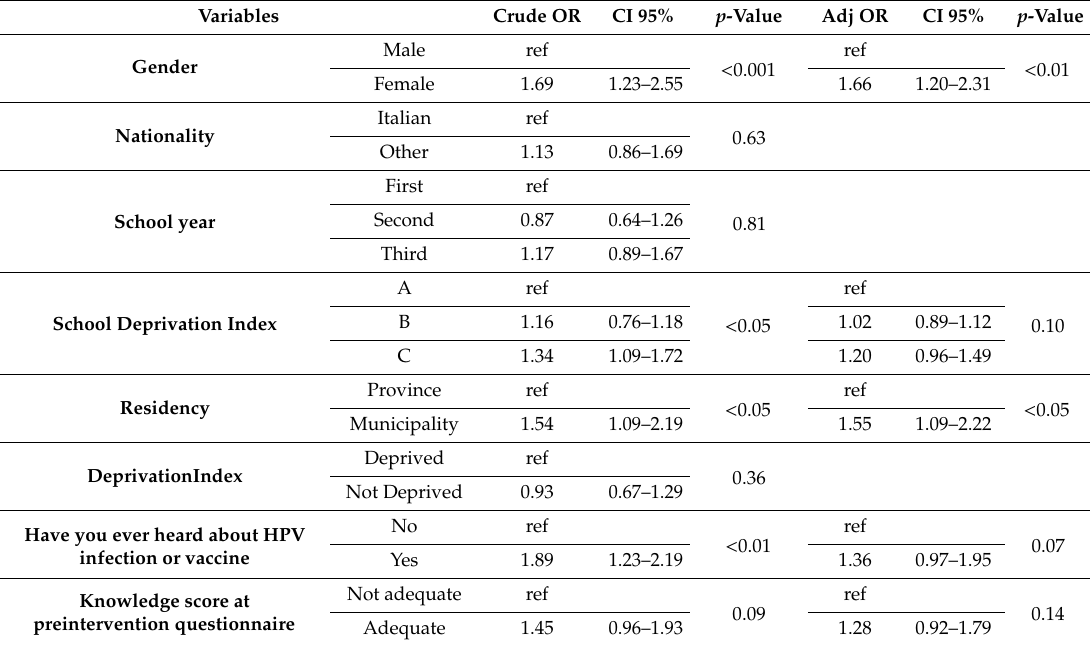
Table 5. Crude ORs and Adjusted ORs of variables associated with an increase in willingness to receive HPV vaccination after the intervention conducted at